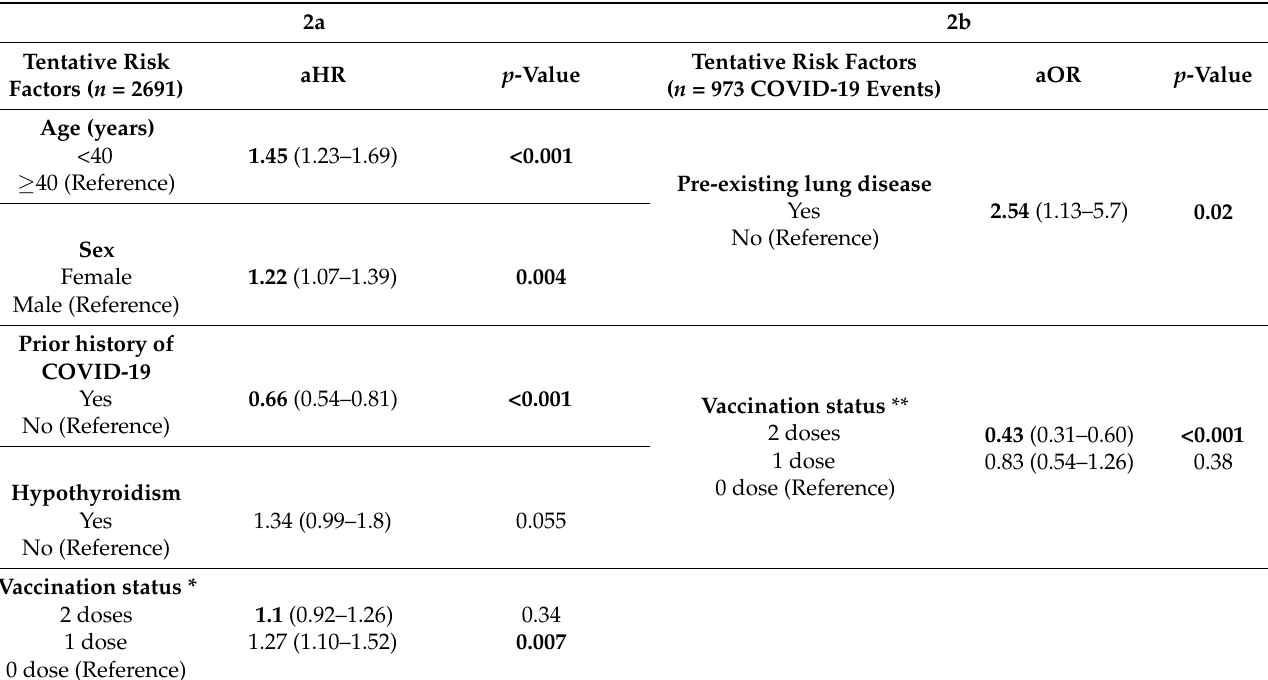
Table 2. Regression analyses to determine tentative risk factors for occurrence and severity of COVID-19 during the second wave of pandemic between 16 March and 31 May 2021. 2a 2b Tentative Risk Factors ( n = 973 COVID-19 Events)